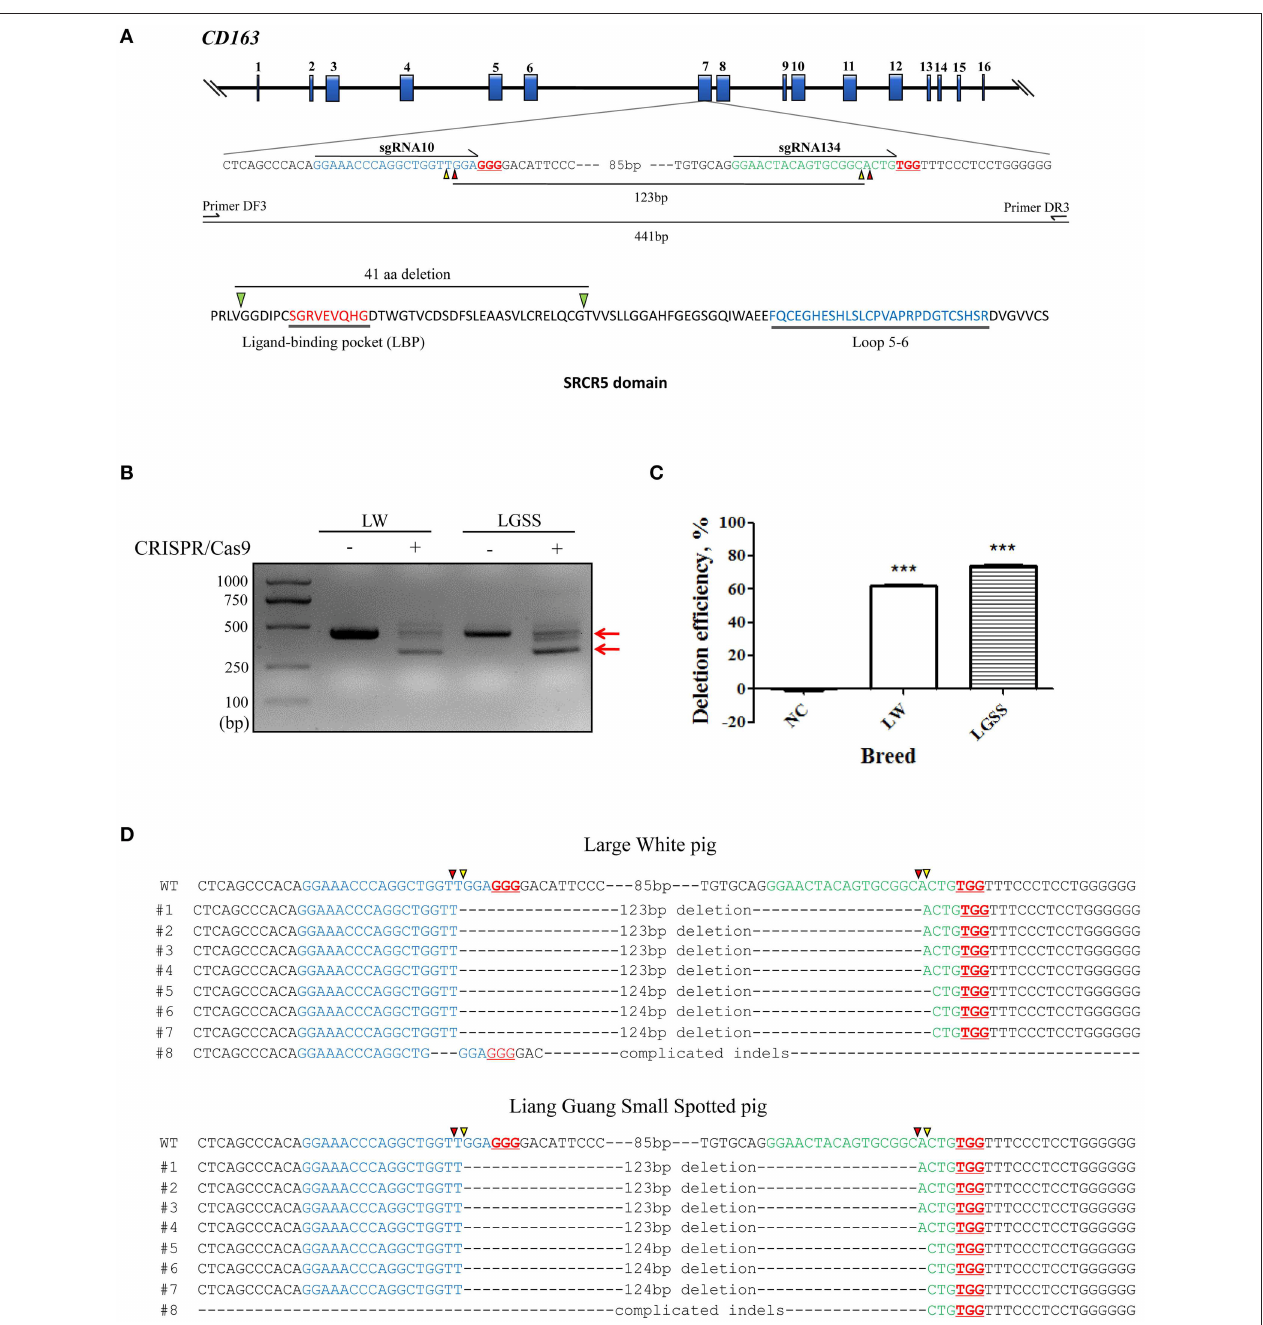
FIGURE 1 | Generation of the precise partial deletion of CD163 SRCR5 in porcine embryonic fibroblasts (PEFs) using CRISPR/Cas9. (A) Schematic of the CD163 gene and target sites of sgRNAs designed for targeting SRCR5 in the exon 7. The 16 exons of CD163 are indicated by blue rectangles. Arrows indicate the sequence used for the guide segment of sgRNA10 and 134. The NGG nucleotide protospacer adjacent motif sequences are underlined in red. Red and yellow triangles represent the predicted cleavage sites of sgRNAs. A precise excision with paired sgRNAs results in a 123 bp in-frame deletion including ligand-binding pocket (LBP). The primer pair DF3/DR3 was used to amplify a 441 bp product from the intact allele of CD163 gene and a truncated product of 317 bp if the deletion (123 bp) has occurred. Two regions (LBP and loop 5–6) of SRCR5 are shown. (B) PCR products identifying the presence of the targeted deletion of CD163 SRCR5 induced by paired sgRNAs. The upper red arrow indicates the position of the 441 bp full length PCR product, and the lower red arrow indicates the expected positions of the truncated PCR product in the event of deletion. LW, Large White pig; LGSS, Liang Guang Small Spotted pig; M, marker. (C) The efficiency of the targeted deletion in PEFs was quantified by qPCR. *** p < 0.001 compared to negative control. (D) Sequence analysis of cloned PCR products. The guide segments of sgRNA 10 and 134 are shown in blue and green, respectively. Red and yellow triangles represent the predicted cleavage sites of sgRNAs. WT, wild-type DNA sequence. Data are representative of the results of three independent experiments (means ± SE). Significant differences are indicated as follows: *** p < 0.001.